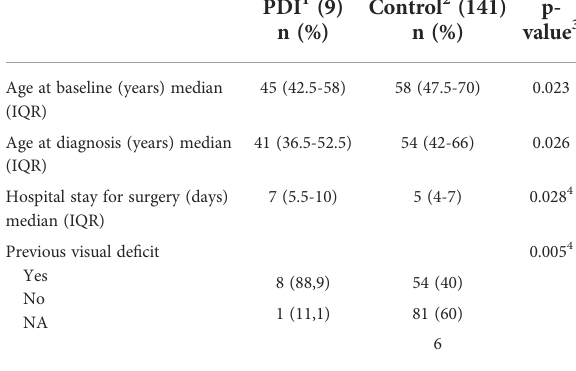
TABLE 4 Permanent Diabetes